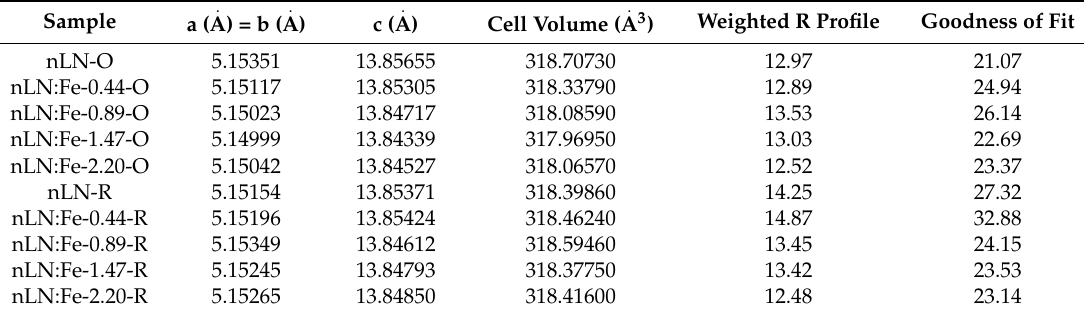
Table 1. Refined lattice parameters and cell volumes, along with relevant agreement